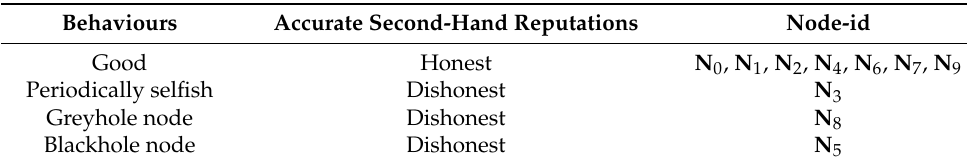
Table 5. Behaviours displayed by the various nodes. Behaviours Accurate Second-Hand Reputations Node-id